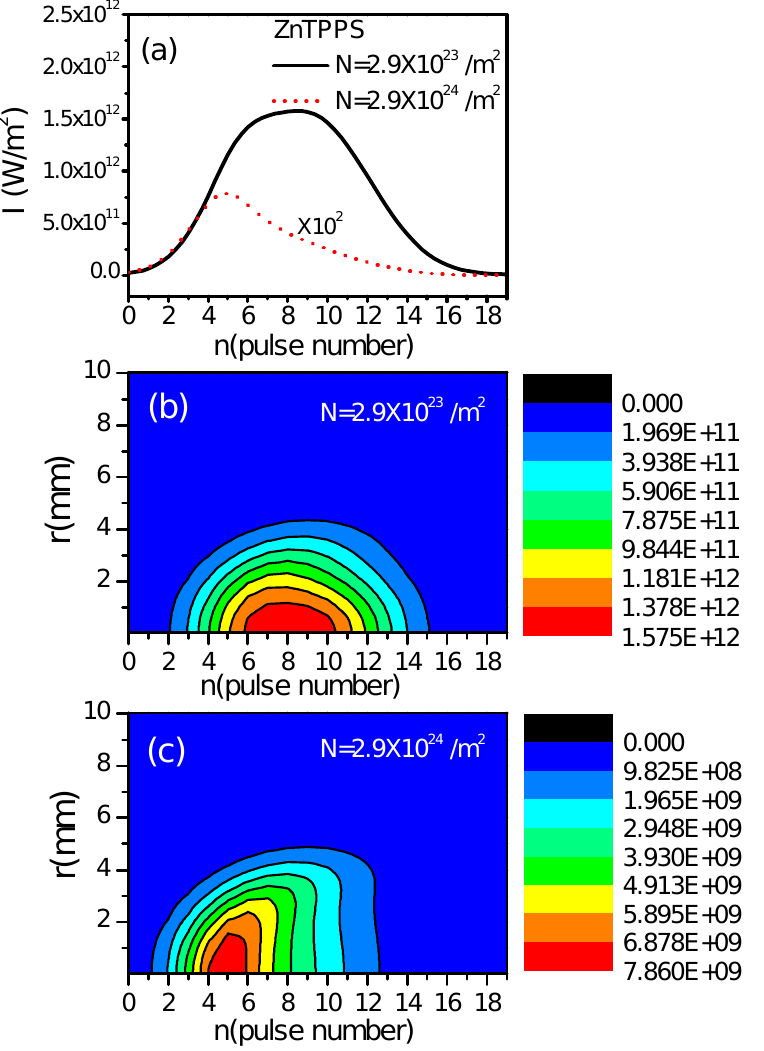
Figure 7. The laser intensities after absorbing at L = 1.0 mm with I 0 = 1.0 × 10 13 W/m 2 for ZnTPPS in aqueous solutions. ( a ) the intensities at r = 0; ( b ) two-dimensional picture with N = 2.9 × 10 23 /m 3 ; ( c ) two-dimensional picture with N = 2.9 × 10 24 /m 3